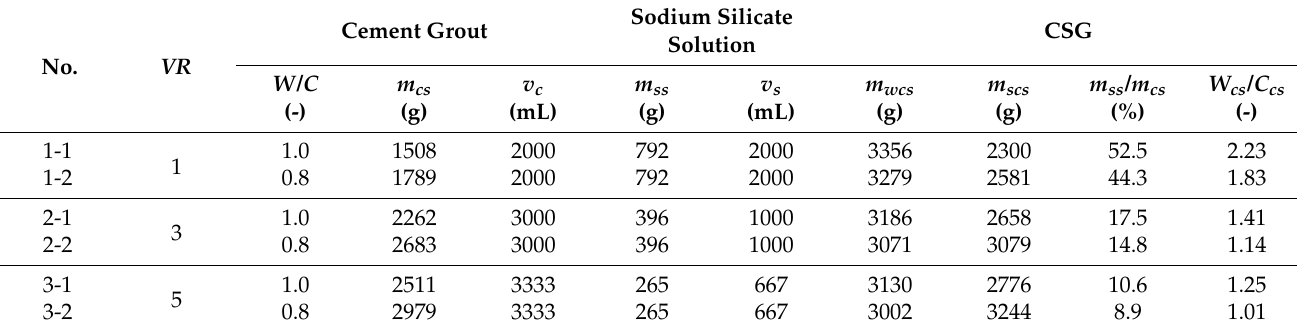
Table 2. Mixing proportions of CSG in different preparation